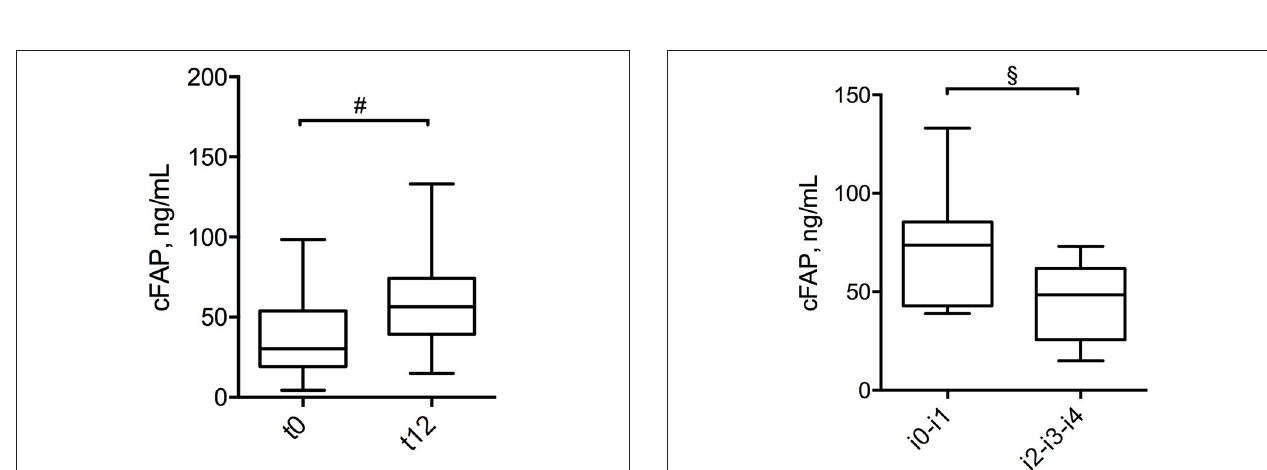
FIGURE 4 | Box plot displaying the concentration of cFAP in patients with CD who have attained endoscopic remission (Rutgeerts score i0, i1) and in those with post-surgery recurrence (Rutgeerts score i2, i3, i4). Statistical analysis was performed by Mann Whitney test, § p =